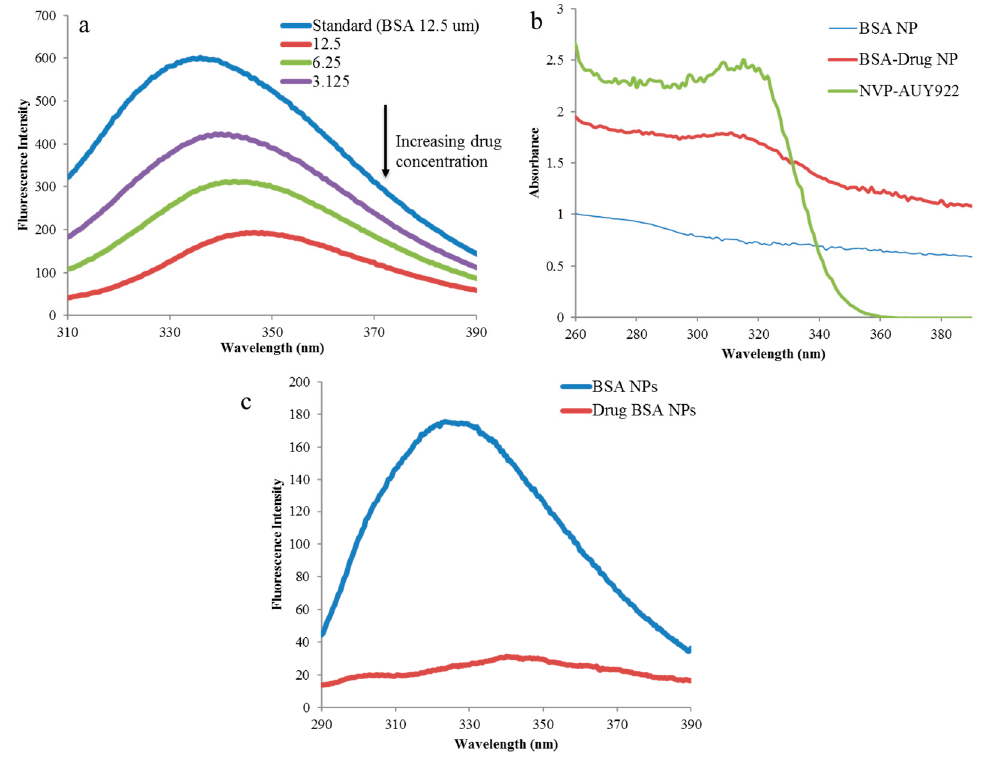
Figure 4. ( a ) Fluorescence quenching when BSA interacts with luminespib while formation of drug BSA nanoconjugates; ( b ) DNPs when subjected to UV absorptions studies, it shows presence of a peak around 310 nm, the same as that of the native drug and blank BSA NPs as controls; ( c ) DNP nanodispersion in PBS 7.4 pH at 1 mg/mL concentration was studied with fluorescence spectroscopy where native BSA NPs were taken as control.